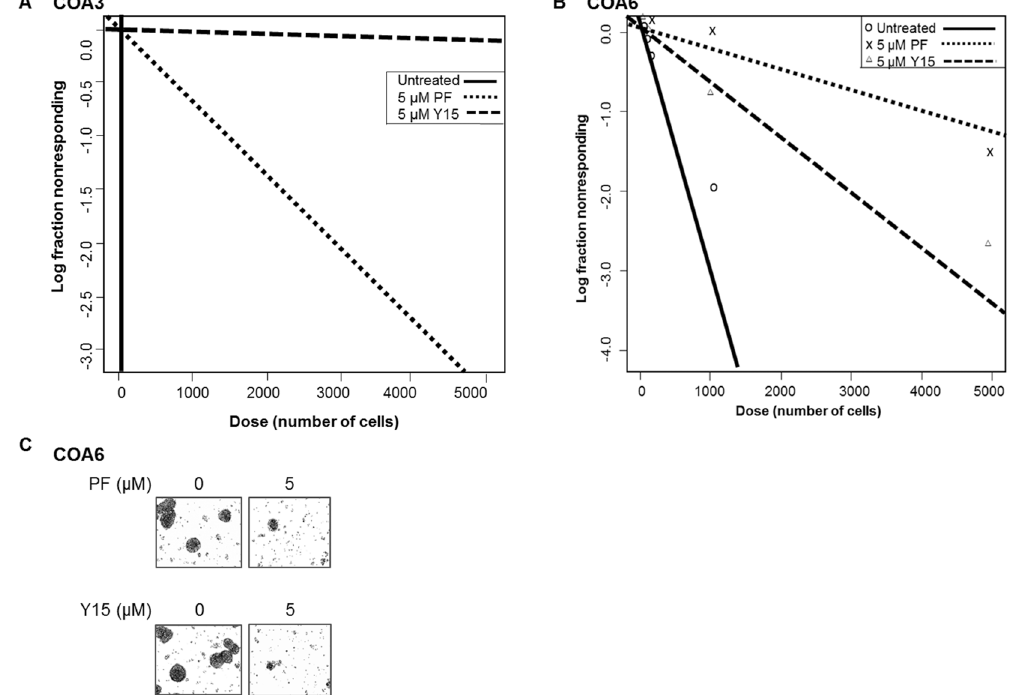
Figure 6. FAK inhibition decreased tumorsphere forming capacity. Single cells of ( A ). COA3 or ( B ). COA6 were plated in conditioned NB media onto 96-well low attachment plates using serial dilutions with 5000, 1000, 100, 50, 20, 10, and 1 cell per well. Cells were then treated with PF (0, 5 μ M) or Y15 (0, 5 μ M). After one week the number of wells containing tumor spheres in each row was counted by a single researcher and the results were analyzed using the extreme limiting dilution analysis software (http://bioinf.wehi.edu.au/software/elda/). After one week, photos of the wells were obtained. Treatment with 5 μ M of either PF or Y15 caused a significant decrease in the tumorsphere formation in COA3 ( A ) and COA6 cells ( B ), indicating a decrease in SCLCC phenotype. C . Representative photographs demonstrate decreased number of tumorspheres following FAK inhibition with PF (top panel) or Y15 (bottom